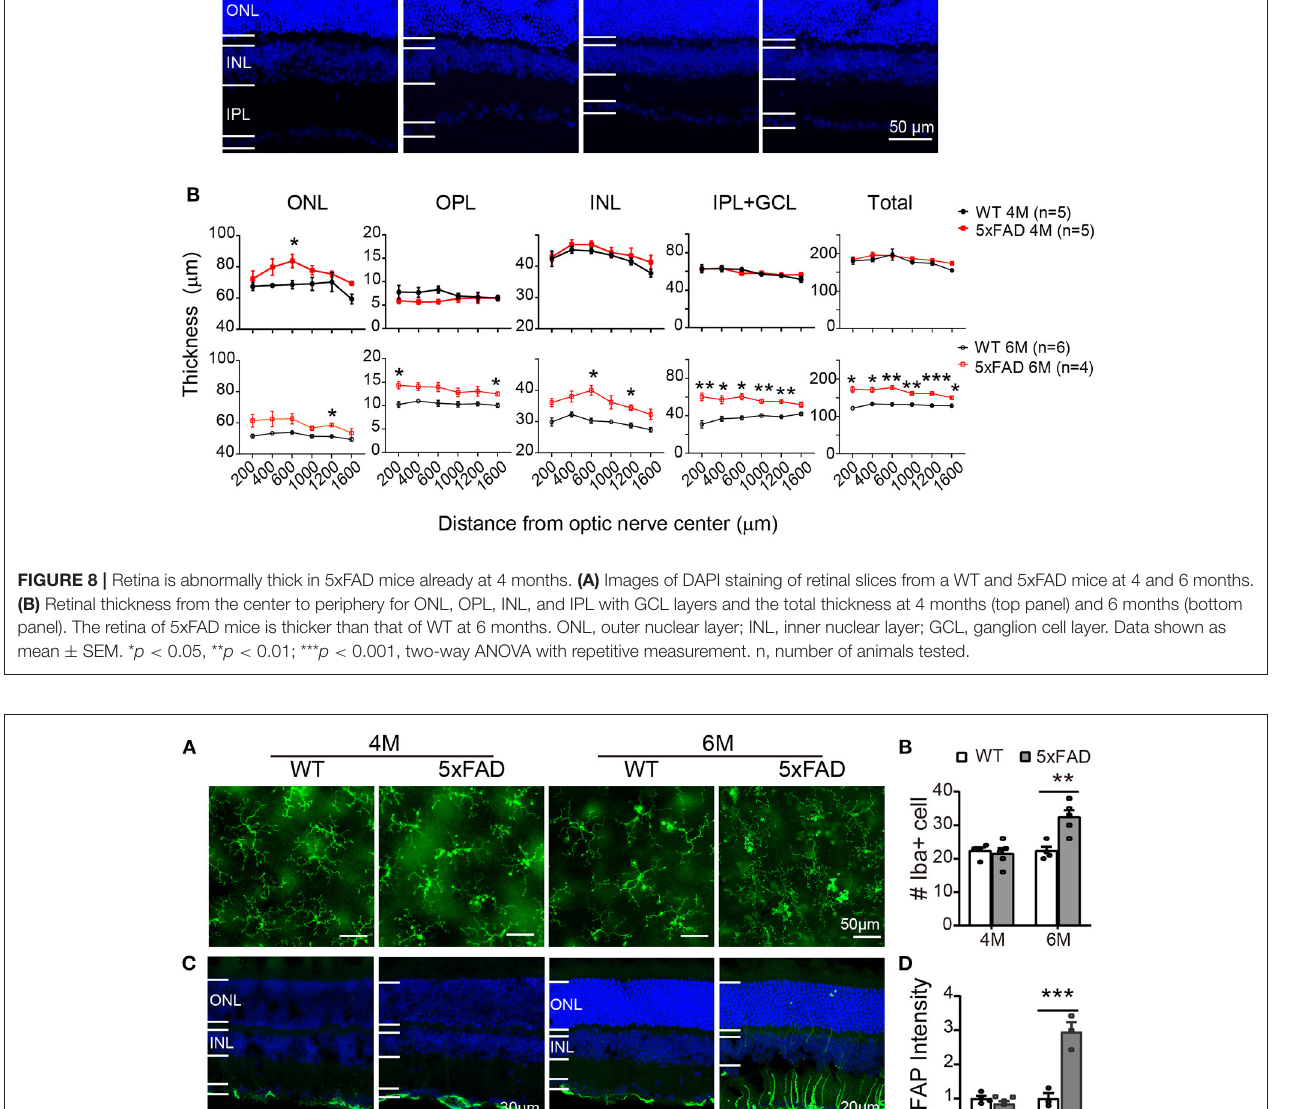
3xTg mice (Song et al., 2020), and APP1/PS1 (Georgevsky et al., 2019), a thinning of the retinal layers was reported at late